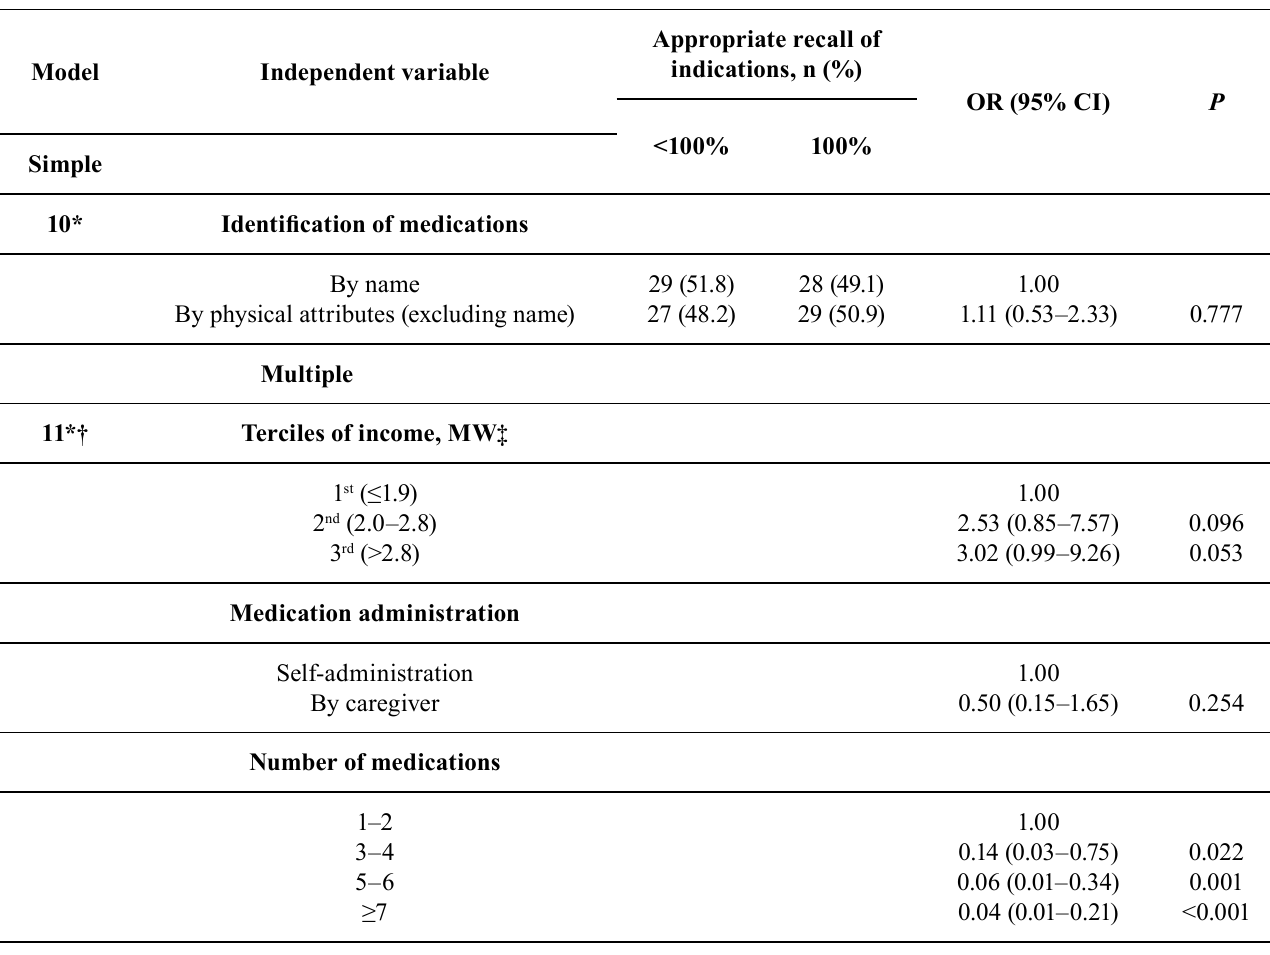
TABLE III – Simple and multiple logistic regression models predicting the appropriate recall of 100% of indications (N = 117)